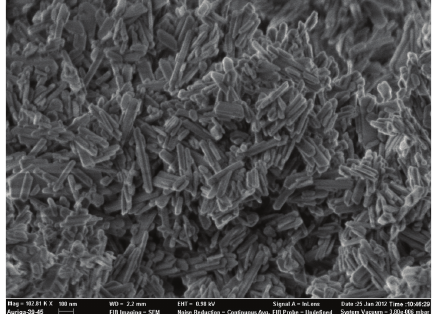
Figure 1: SEM image of synthesized